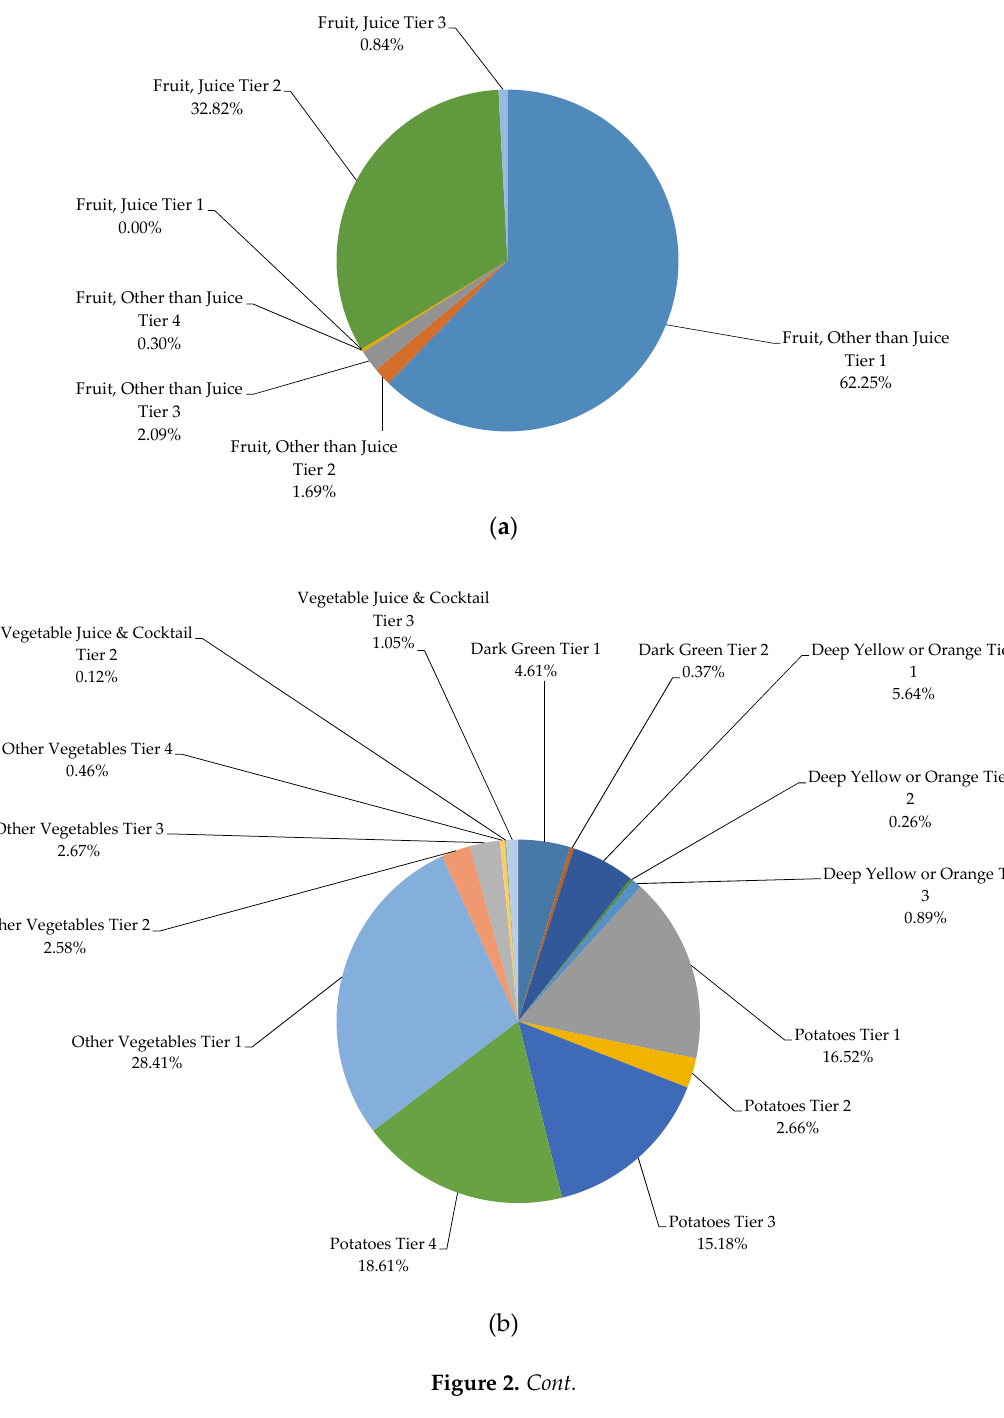
Figure 2. Cont. Figure 2.